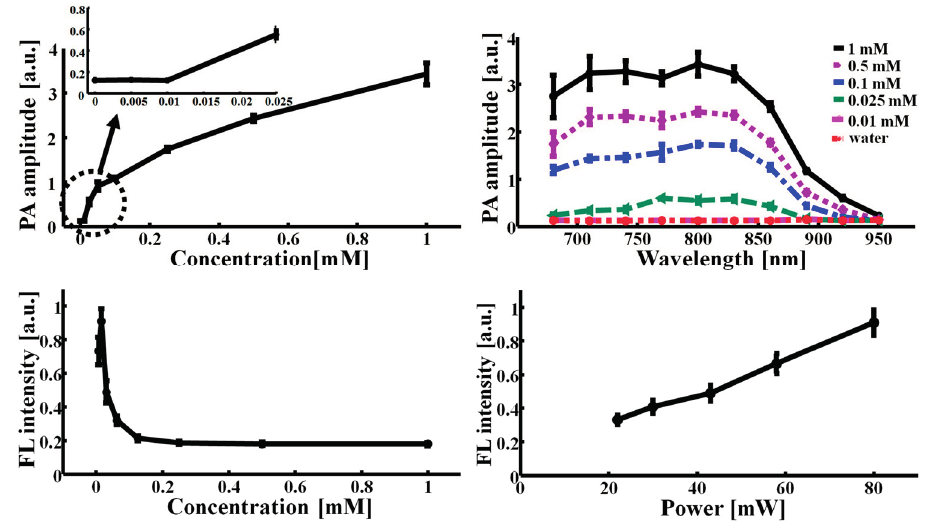
Figure 2. Photoacoustic (PA) and fluorescence (FL) properties of indocyanine green (ICG). ( a ) PA amplitudes vs. ICG concentration; ( b ) PA spectra of ICG by varying concentration; ( c ) FL intensities vs. ICG concentration; ( d ) FL intensities vs. LED output